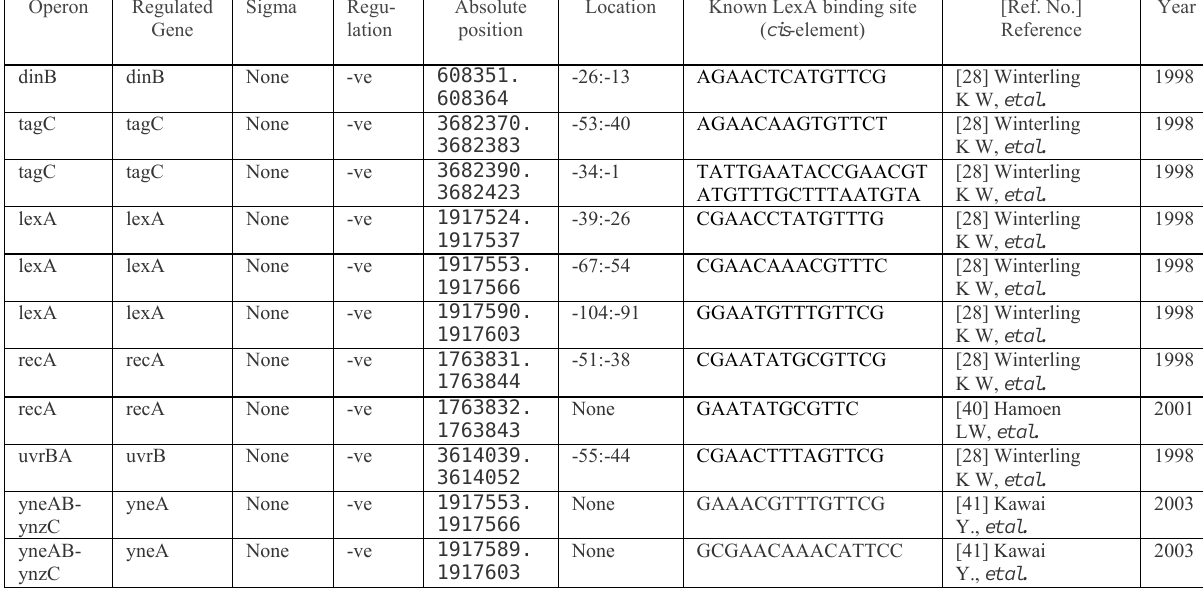
Table 2: List of the known LexA TFBS characterized in B. subtilis genome retrieved through DBTBS; a database of transcriptional regulation in B. subtilis . The SOS-box consensus sequence of B. subtilis is CGAACRNRYGTTCG for binding of LexA, defined as negative (-ve) regulator of DNA damage-inducible genes; SOS-like or SOB regulon; analogue of E. coli